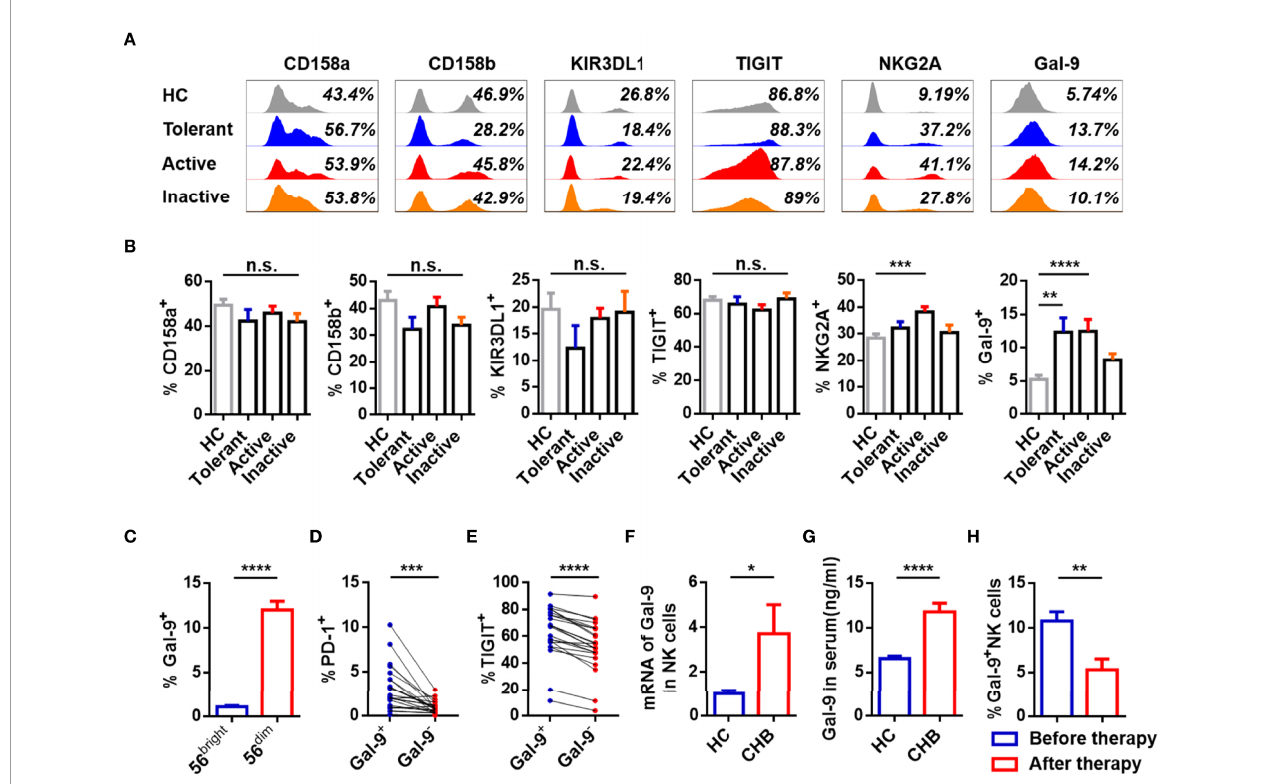
FIGURE 1 | Expression of Gal-9 is increased and associated with functional impairment in NK cells of CHB patients. (A) Representative fl ow cytometry plots showing expression of the inhibitory receptors, CD158a, CD158b, KIR3DL1, TIGIT, NKG2A, and Gal-9 on circulating NK cells in the Tolerant, Active, and Inactive groups of CHB patients and HCs. (B) Comparison of the proportion of receptors expressed on circulating NK cells in (A) . (C) Comparison of Gal-9 expression in circulating CD56 bright NK cells and CD56 dim NK cells in CHB patients. (D) Comparison of the PD-1 expression levels in circulating Gal-9 + NK cells and Gal-9 - NK cells in patients with CHB. (E) Comparison of the TIGIT levels in circulating Gal-9 + NK cells and Gal-9 - NK cells in patients with CHB. (F) Gal-9 mRNA expression in circulating NK cells from CHB patients and HCs. (G) Gal-9 expression in serum from CHB patients and HCs. (H) Comparison of the Gal-9 expression levels in NK cells in peripheral blood of CHB patients with or without antiviral treatment, respectively. Results are expressed as the mean ± SEM, and the number of samples (n) in each group was ≥ 3. One-way ANOVA test was conducted for four-group comparisons. Groups with signi fi cant differences are marked, and the unmarked paired groups have no differences. Unpaired t-test was used to compare two independent groups. A paired t-test was used to compare paired samples. *P < 0.05; **P < 0.01; ***P < 0.001; ****P < 0.0001; n.s., not signi fi